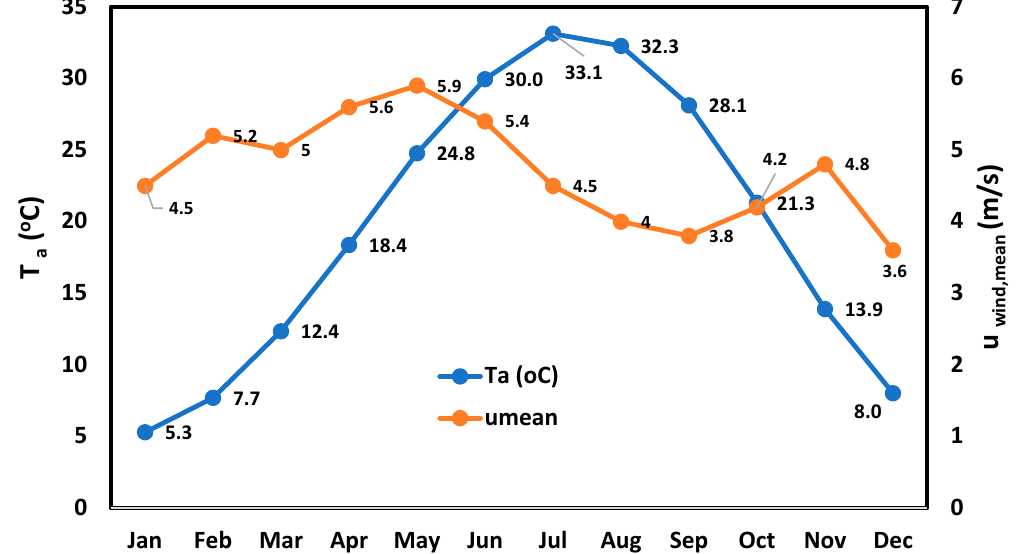
Figure 4. Monthly average air temperature and wind speed in different months of a year.